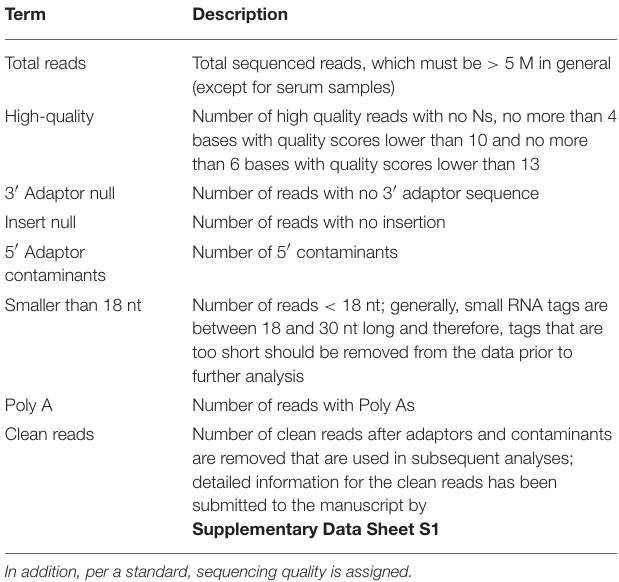
TABLE 1 | The sequencing chromatogram is converted into sequence data during the base calling step.